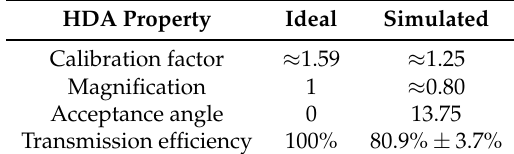
Table 1. Simulated electron spectrometer figures of merit for machined geometry with real specifications compared with simplified geometry and no fringing fields which represents the upper bound on performance. Hemispherical deflection analyzer (HDA).